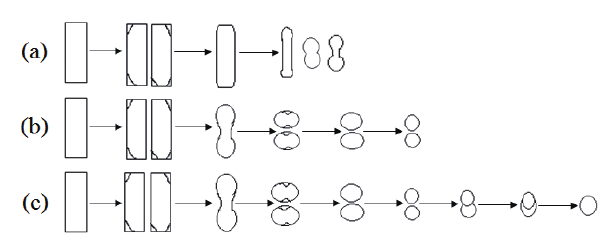
FIGURE 7 - The probable formation mechanisms of pellets in spheronization process(a) clavate, double sphere or dumb-bell shaped pellets; (b) spherical pellets;(c) oversized